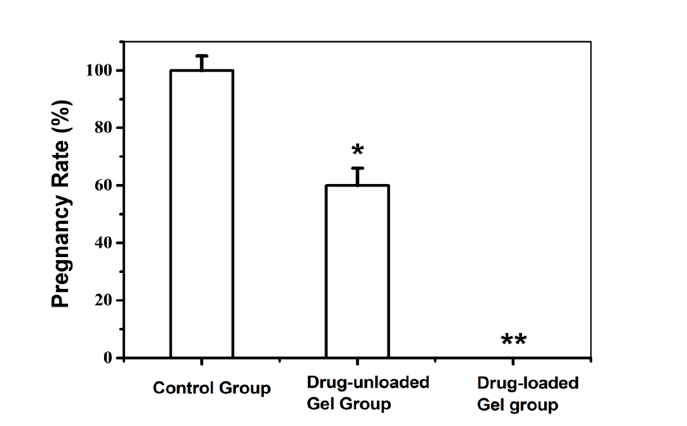
Figure 9. The pregnancy rate of female Sprague ‐ Dawley (SD) rats treated with CP ‐ 3 block copolymer hydrogels loaded with Indomethacin (IMC), Gestodene (GSD), and Ethinyl Estradiol (EE) mixed drugs (low dosage) and bare CP ‐ 3 block copolymer hydrogels, the SD rats without injected hydrogels as a control group. The concentration of copolymer was 30 wt%, the volume of drug ‐ loaded copolymer solution injected into the vagina is 0.2 mL. ** p < 0.01, * p < 0.05.